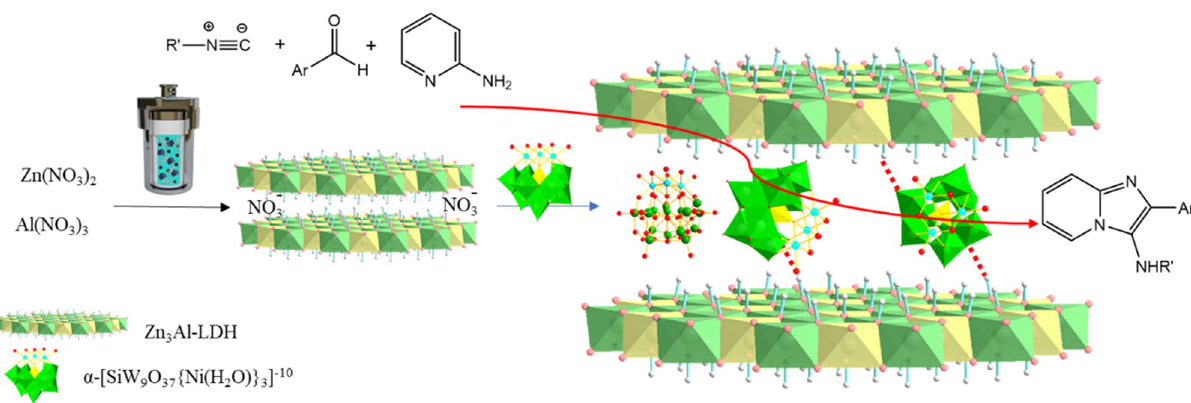
Figure 1. Illustration of the procedure for the SiW 9 Ni 3 @Zn 3 Al nanocomposite and the synthesis route of amino imidazothiazole over the POM–LDH